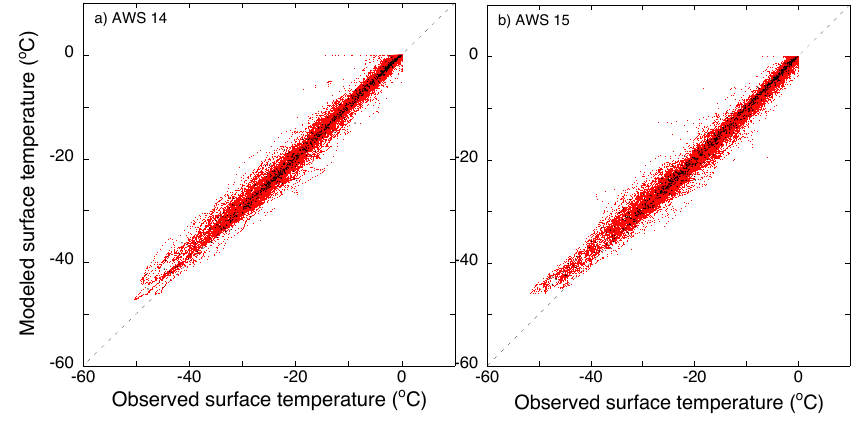
Fig. 6. Model performance check by comparing observed values of surface temperature to computed values, for (a) AWS 14; and (b) AWS 15. Red dots are hourly values, whereas black dots are daily-mean values.